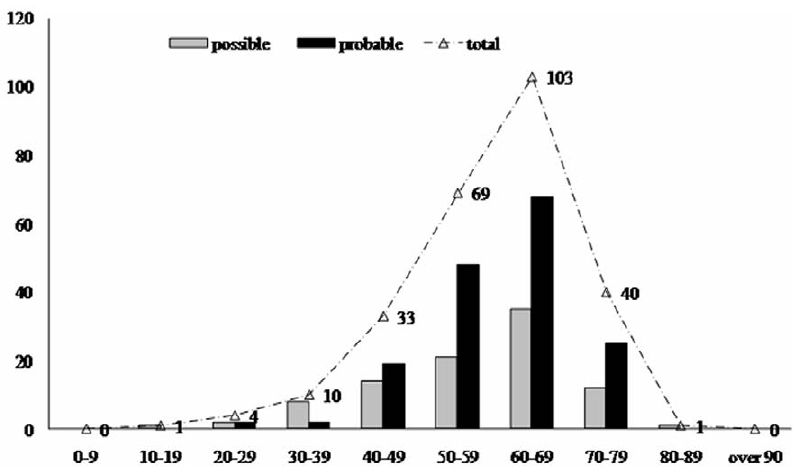
Figure 1. The age distribution of probable and possible sCJD cases. The black column indicates probable sCJD, the grey column indicates possible sCJD and the curve represents the total numbers.